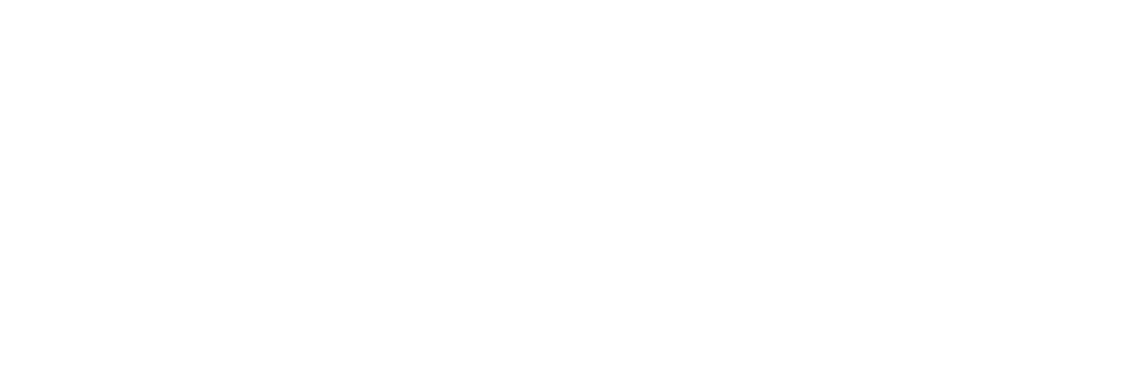
Frontiers in Microbiology | Aquatic